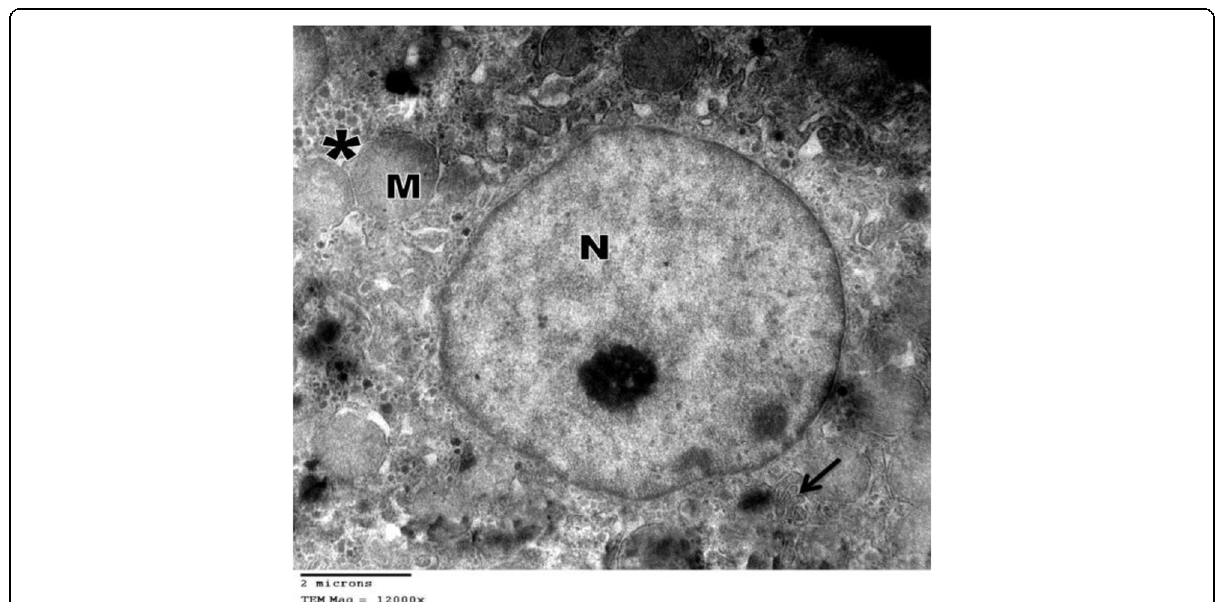
Fig. 19 An electron micrograph of a hepatocyte of treated mouse with Tamiflu (16 mg/kg b.wt.) for 15 days illustrating swollen mitochondria